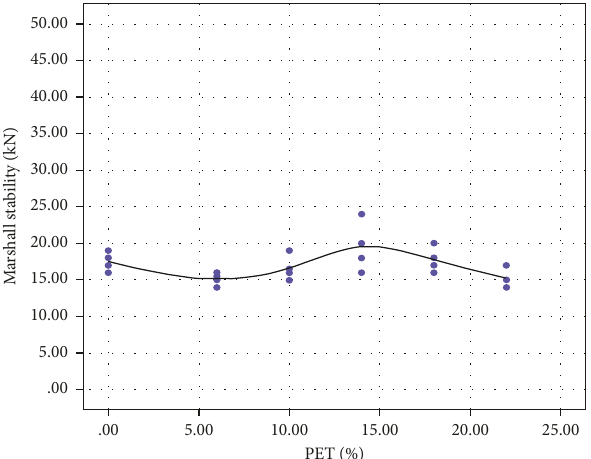
Figure 4: Marshall stability for different percentages of PET additions.